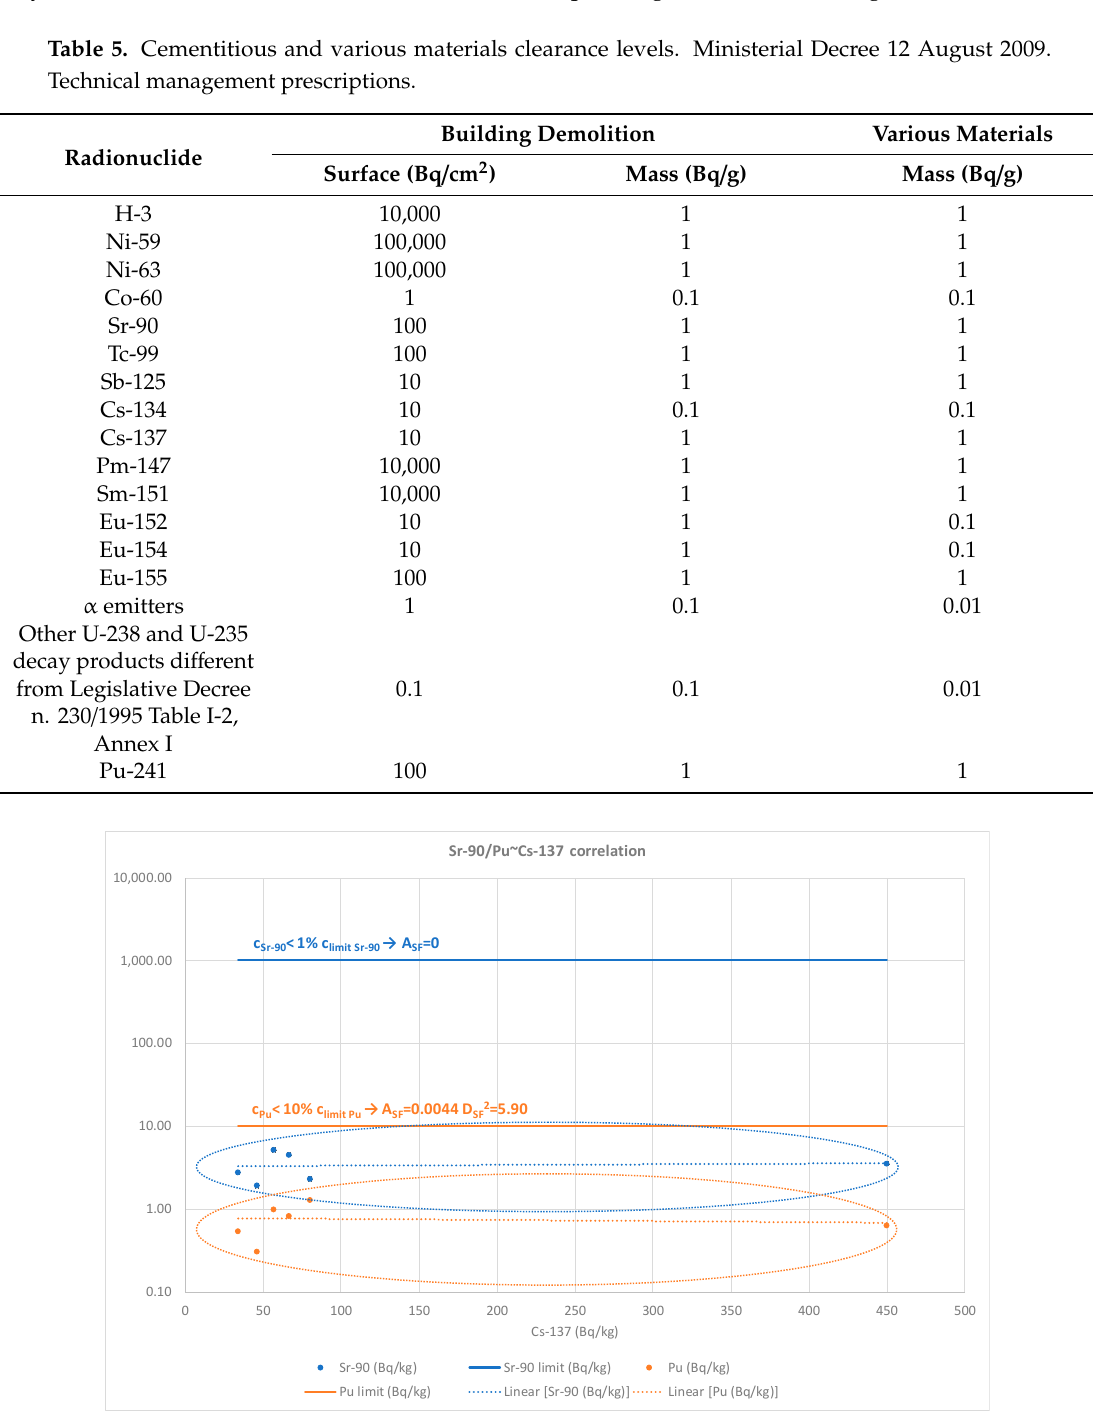
Figure 10. Sr-90/Pu~Cs-137 correlation present in the Saluggia “EUREX” nuclear installation soils Figure 10. Sr-90 / Pu~Cs-137 correlation present in the Saluggia “EUREX” nuclear installation samples. soils